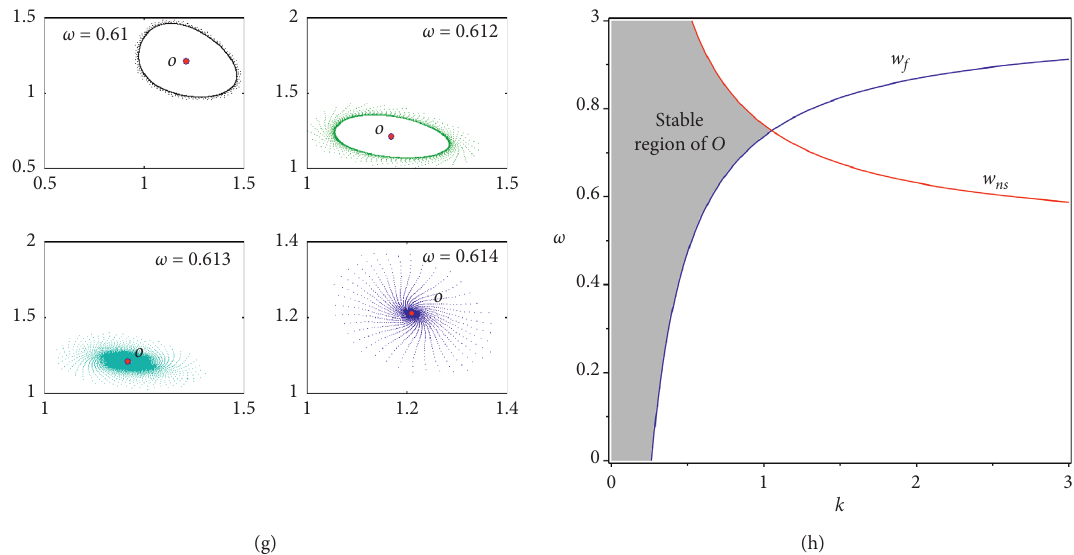
Figure 4: (a) Bifurcation diagram of ω at k � 1 . 4. (b) Phase plane for four disconnected closed rings at ω � 0 . 323 and k � 0 . 68. (c) The attractive basins of period-4 cycle and chaotic attractor at ω � 0 . 33254 and k � 0 . 68. (d) The phase plane of strange attractor around O at ω � 0 . 387 and k � 0 . 68. (e) The attractive basins of period-9 cycle with chaotic attractor at ω � 0 . 4313 and k � 0 . 68. (f) The attractive basins of period-4 cycle with a closed invariant curve at ω � 0 . 5 and k � 0 . 68. (g) Different dynamic behaviors at ω � 0 . 6 . 1 , 0 . 612 , 0 . 613 , 0 . 614 and k � 1 . 4. (h) The stability region and chaos routes via the Neimark–Sacker and flip bifurcations. The other values of parameters are a � 1 . 4 and c � 0 .